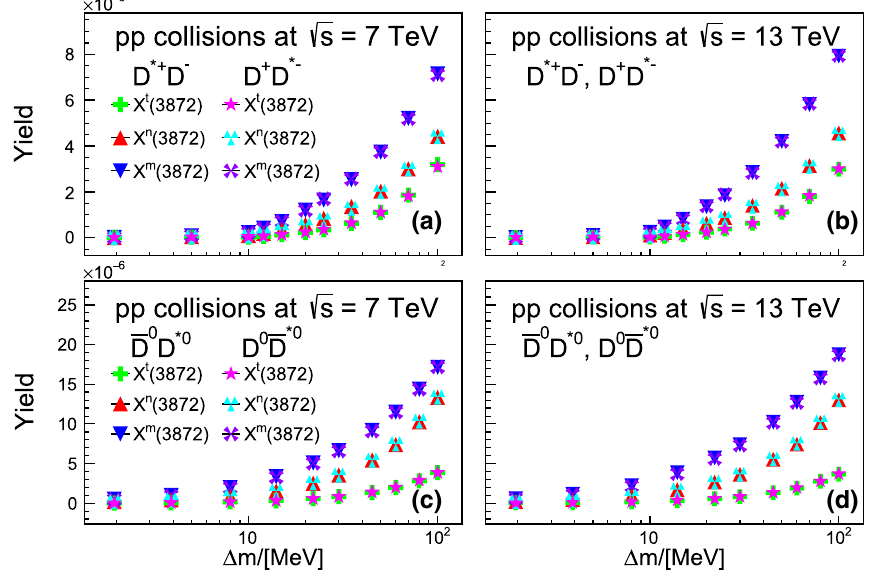
√ s = 13 TeV, c as X ( 3872 ) consists of the bound state ¯ D 0 D ∗ 0 and √ D 0 ¯ D ∗ 0 at s = 7 TeV, d as X ( 3872 ) consists of the bound states √ ¯ D 0 D ∗ 0 and D 0 ¯ D ∗ 0 at s = 13 TeV. In the figure, symbols with dif- ferent shapes and different colors are used to represent different exotic √ s = 7 TeV, states X ( 3872 ) constructed by different bound states D ¯ D ∗ √ s = 7 , 13 TeV with | y | < 1 , 0 < p T < 15 . 5